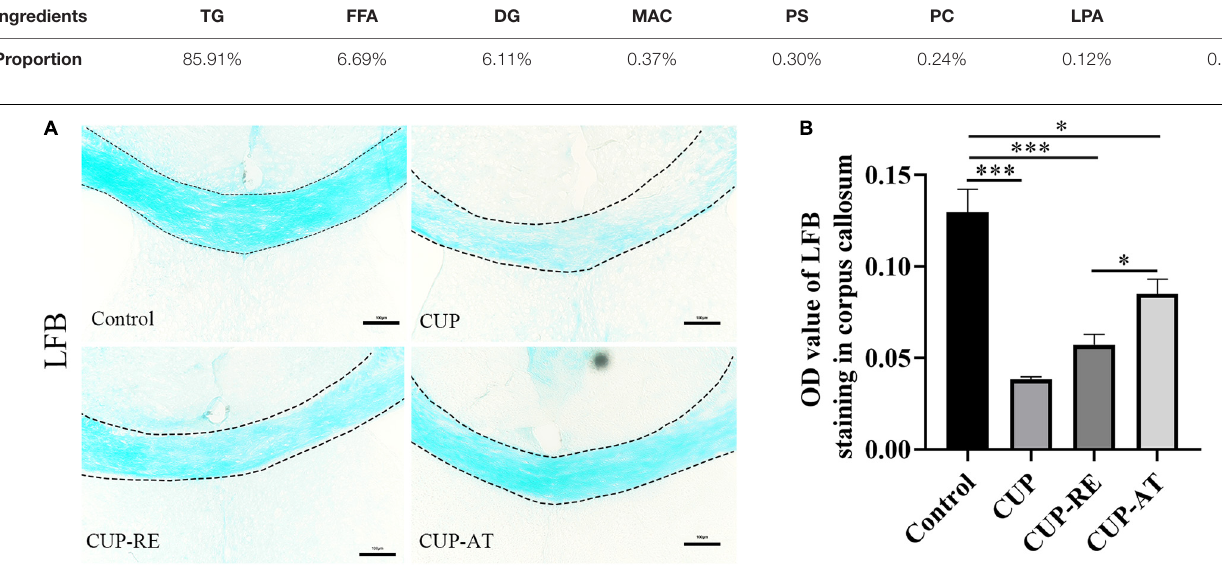
FIGURE 3 | Administration of CUP induced demyelination of the corpus callosum and dietary Acer truncatum oil promoted remyelination in the corpus callosum. (A) LFB staining in the corpus callosum. The corpus callosum in control group was densely and regularly labeled with LFB, whereas the LFB staining in mice administrated with CUP became light and irregular. After dietary Acer truncatum oil, the LFB staining recovered almost like that in control group. (B) Quantitative analysis of OD value of LFB in the corpus callosum. Acute CUP administration significantly reduces the OD value of LFB. Dietary Acer truncatum oil rescued the reduction of OD value of LFB. n = 3–4/group. Scale bar: 100 µ m. Data were expressed as means ± SEM. Differences between groups were expressed as ∗ p < 0.05, ∗∗∗ p <